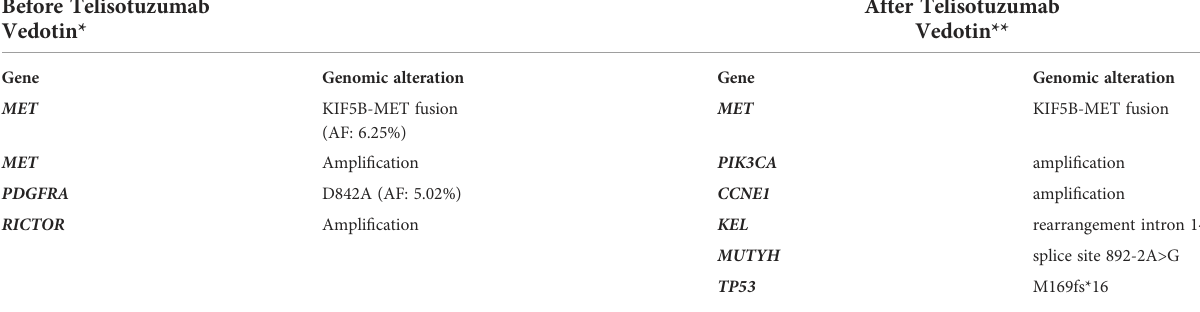
TABLE 1 Results from NGS testing before and after Telisotuzumab Vedotin. Before Telisotuzumab Vedotin*